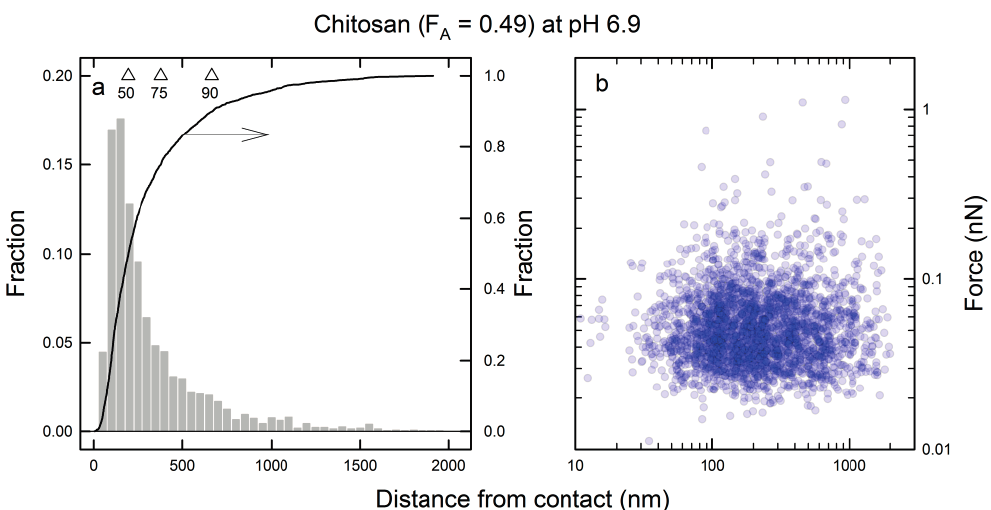
Figure 4. Statistical information from unbinding events for chitosan ( F A =0.01)–mucin interactions at pH 6.9 (25 mM Hepes buffer, 150 mM NaCl). ( a ) Histogram and cumulative (line) distribution of unbinding events versus distance from contact of the tip with the surface. The median (50%), 75% and 90% percentiles of the cumulative distribution are depicted (triangles); ( b ) Scatter plot of observed unbinding forces versus distance from contact. This scatter plot is shown on double logarithmic scales to provide some separation of the various observations, with a transparent fill